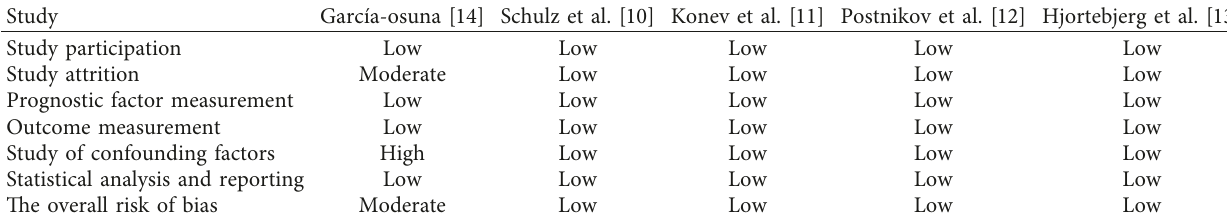
Table 1: QUIPS tool for assessment of the risk of bias in the